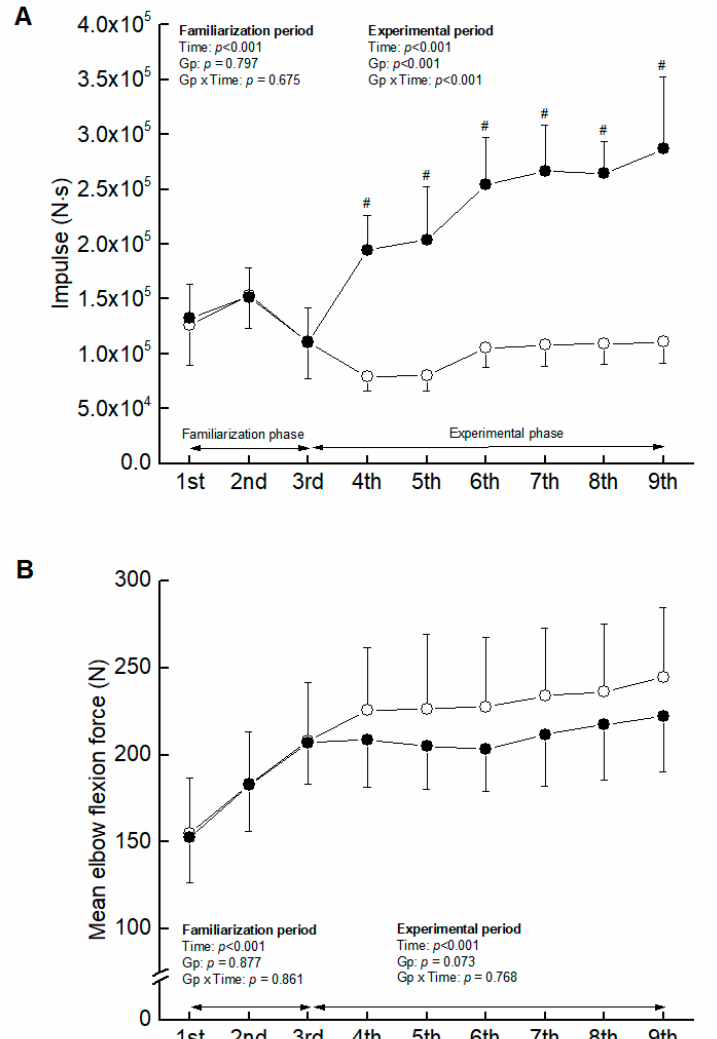
Figure 1. Comparison of impulse ( A ) and mean elbow flexion force exerted ( B ) between ST and COMB in training sessions. The filled and open circles denote COMB and ST, respectively. #, significant group-related difference.